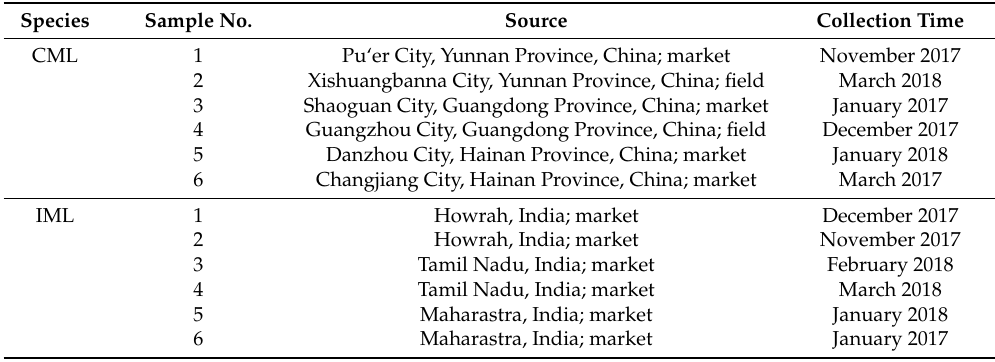
Table 1. The list of the tested samples from China and India. Legend: CML, Chinese Moringa oleifera leaf; IML, Indian Moringa oleifera leaf. Sample